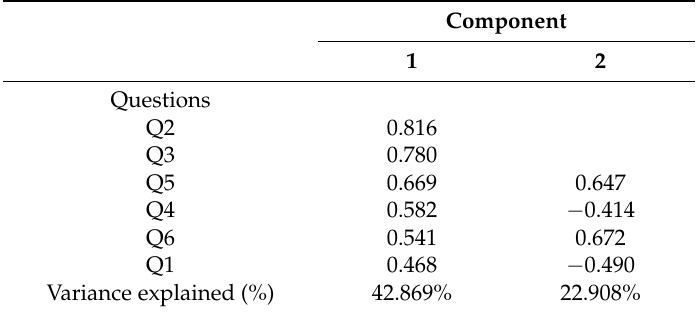
Table 4. Component matrix. This table contains the correlations between the items and the factors with an eigenvalue greater than 1. The percentage of variance explained by each factor is also shown.